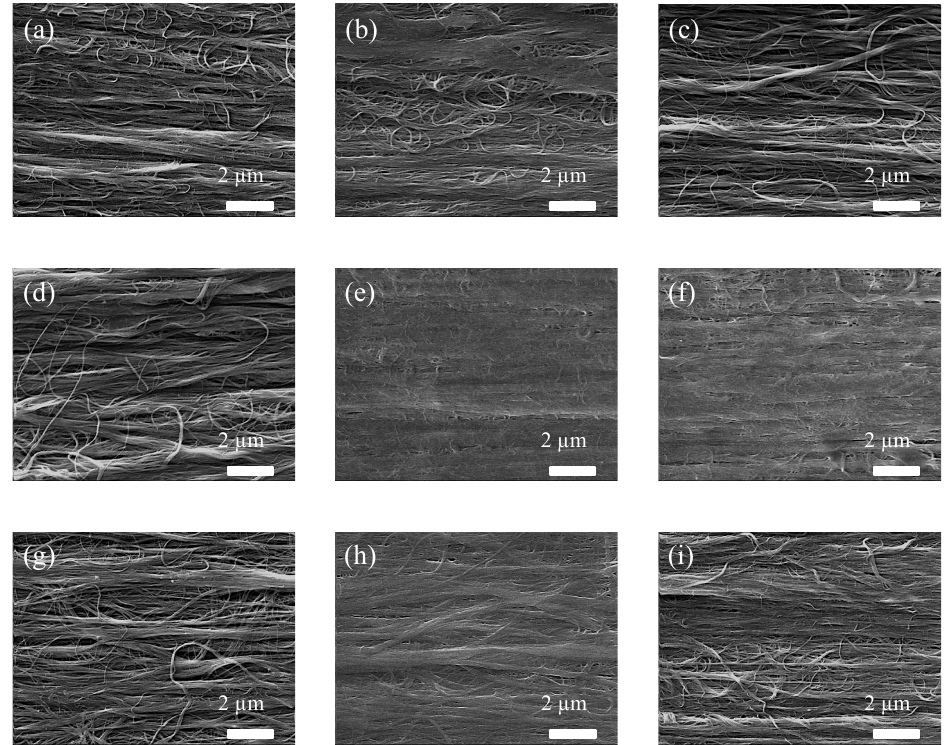
Figure 5. Scanning electron microscope images of PMMA-CNT composites at ( a ) 0.5%, ( b ) 1% and ( c ) 2% wt/vol concentration, TPU-CNT composites at ( d ) 0.5%, ( e ) 1% and ( f ) 2% wt/vol concentration and Ultem TM -CNT composites at ( g ) 0.5%, ( h ) 1% and ( i ) 2% wt/vol concentration.